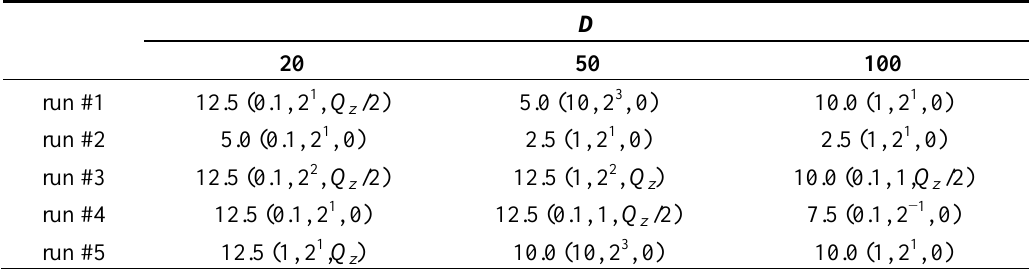
Table 1. Simulation results: problem A,